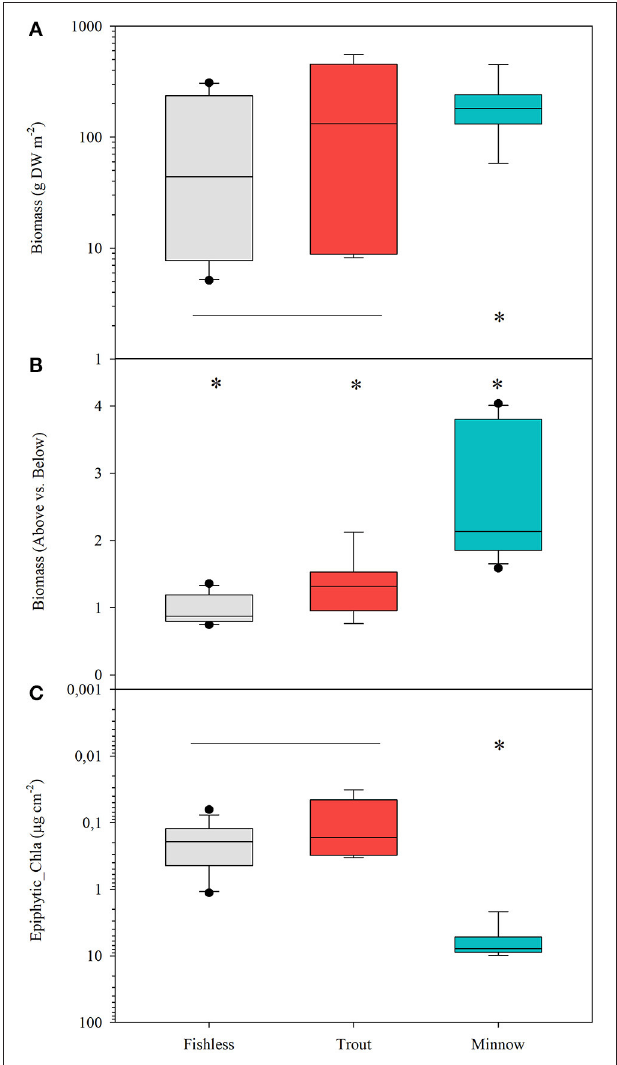
FIGURE 6 | Box plots for (A) total biomass of quillwort meadows in log DW m − 2 , (B) quotient above vs. belowground biomass and (C) load of epiphytes expressed as µ g chl-a cm − 2 of leaf in 10 lakes under the different scenarios; fishless, with tout and with minnows. Differences in the mean values are tested following the ANOVA model; var (x) = Scenario + Lake (Scenario) + error; significant differences are set at p < 0.01. Asterisks denote significantly different from the rest and the horizontal line indicates groups not significantly different.